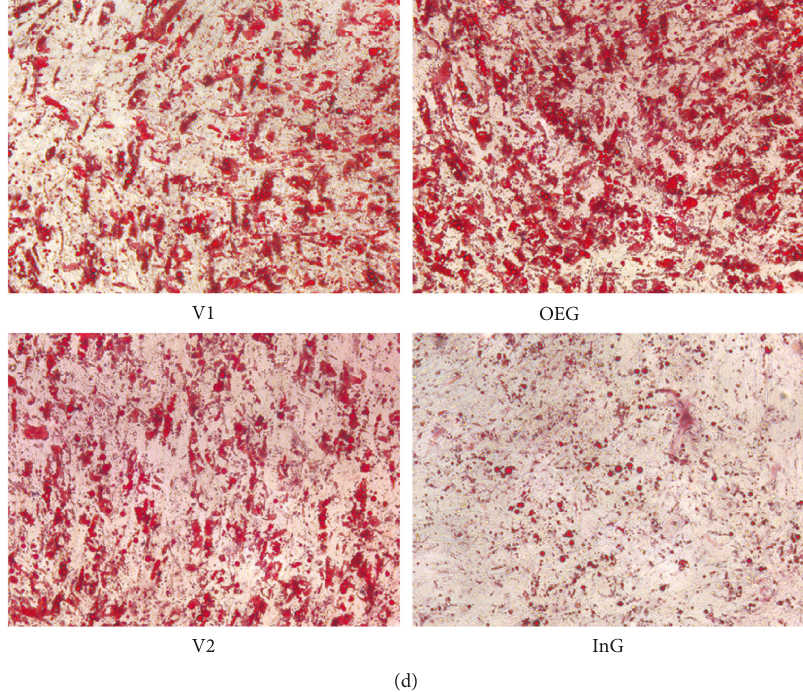
Figure 1: ADMSC transfection and differentiation. (a) GFP expression in OEG, V1, InG, and V2, visualized by fluorescence microscopy. (b) Quantitative RT-PCR analysis of the expression levels of GNPDA2 . The relative expression is shown as the means ± standard deviation of three independent experiments made in triplicates. ∗ p < 0 . 05. (c) Western blot analysis of the protein levels of GNPDA2 . (d) Oil Red O staining after 10 days of culture in adipocyte differentiation inductive medium. OEG: GNPDA2 overexpressed ADMSCs; V1: the control cells of OEG; InG: GNPDA2 shRNA knockdown ADMSCs; V2: the control cells of